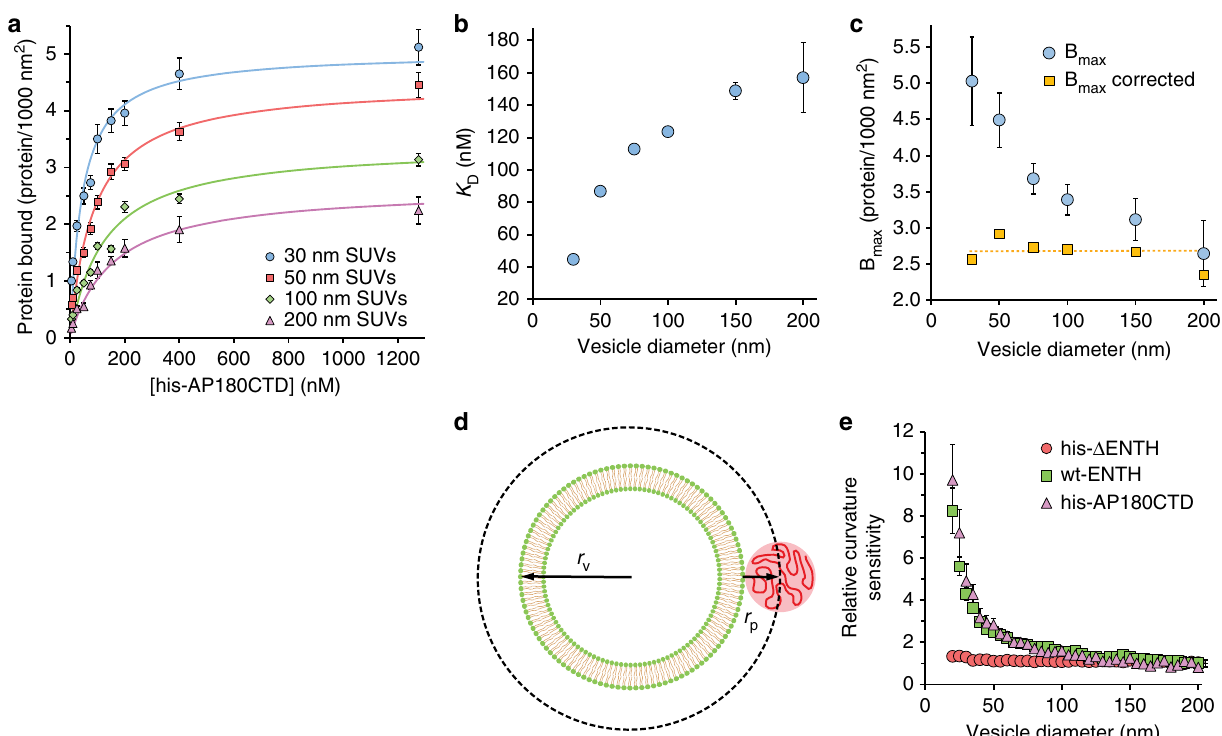
Fig. 2 Impact of membrane curvature on IDP binding equilibria. a Binding curves for his-AP180CTD. b Regressed values for the dissociation constant ( K D ) as a function of SUV diameter. c Regressed values for maximal protein binding ( B max ) as a function of SUV diameter, and the corrected values after geometrical effects are removed. The dashed yellow line represents the average B max corrected value (2.7 × 10 − 3 proteins nm − 2 ) of the six square data points. The experimental results shown as symbols in ( a ) were fi tted to Eq. 1. The resulting fi t parameters are shown in ( b , c ). d Schematic of the geometric effect described by Eq. 2. e Curvature sensitivity comparisons of his- Δ ENTH, wt-ENTH, and his-AP180CTD at approximately 3% average membrane coverage. The solution concentrations required to achieve this level of membrane coverage were 5 nM for his- Δ ENTH, 450 nM for wt-ENTH, and 5 nM for his-AP180CTD. Error bars in ( a , e ) are represented by the 95% con fi dence interval of the mean. Each bin in ( a ) contains N = 23 – 338 data points acquired cumulatively from three independent replicates. Similarly, each bin in ( e ) contains N = 36 – 358 data points. Error bars in ( b , c ) are represented by the standard deviation of three regression values obtained from fi tting the mean, upper error, and lower error bounds in ( a